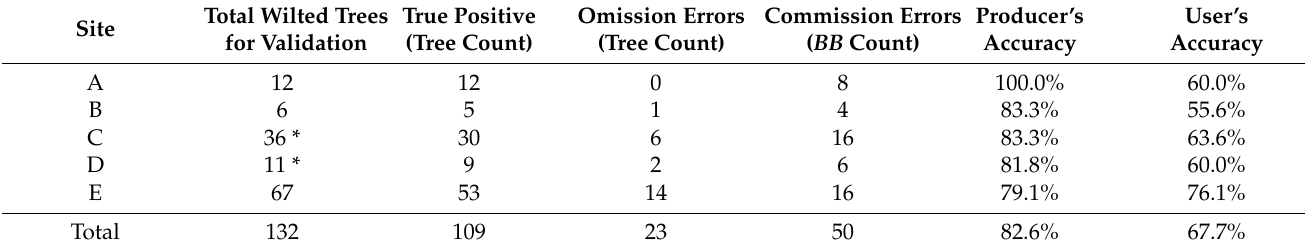
Table 4. Validation results for PWD detection based on the single-date image classification method.